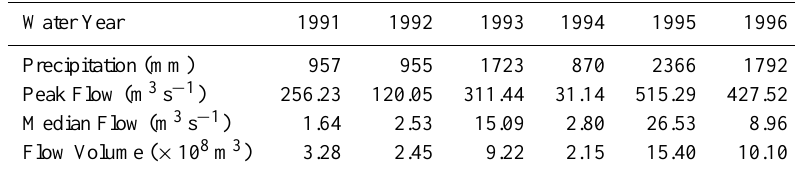
Table 3. Precipitation and observed streamflow characteristics during the prediction